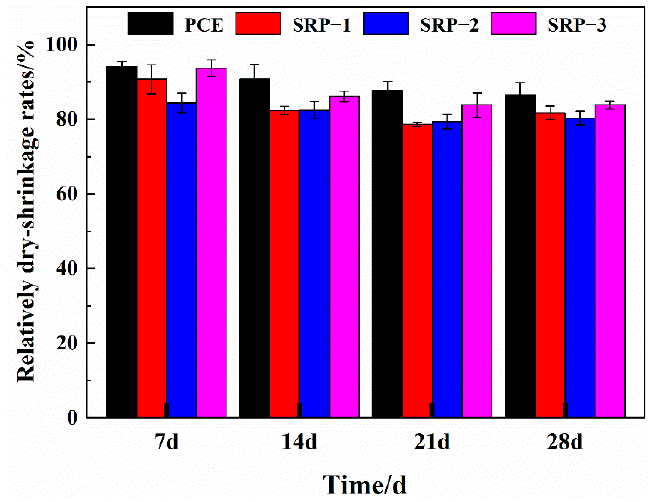
Figure 3. Dry − shrinkage rates of mortars containing PCE or SRP. Figure 3. Dry-shrinkage rates of mortars containing PCE or SRP.